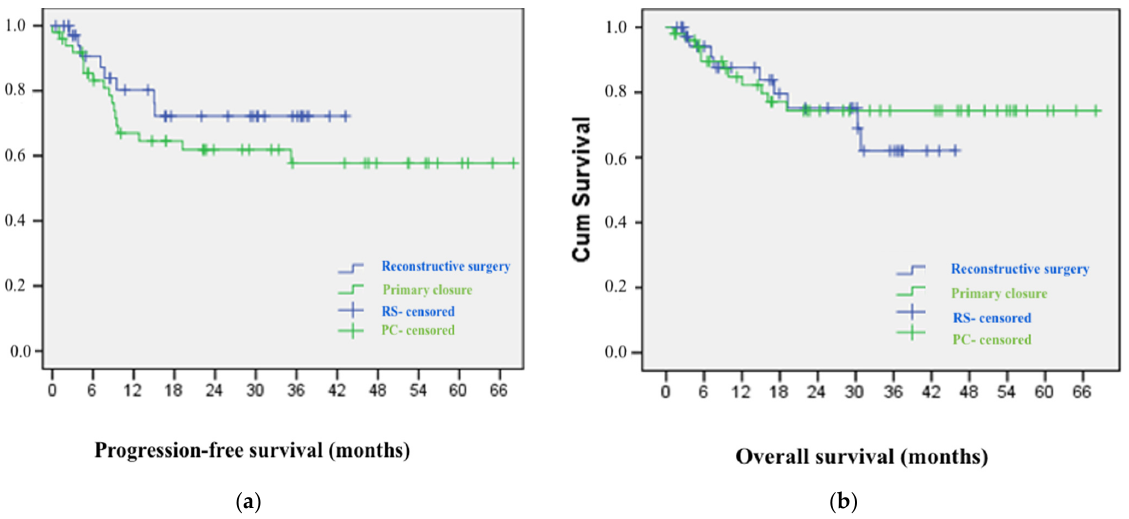
Figure 3. Kaplan-Meier curves of progression-free ( a ) and overall survival in both groups ( b